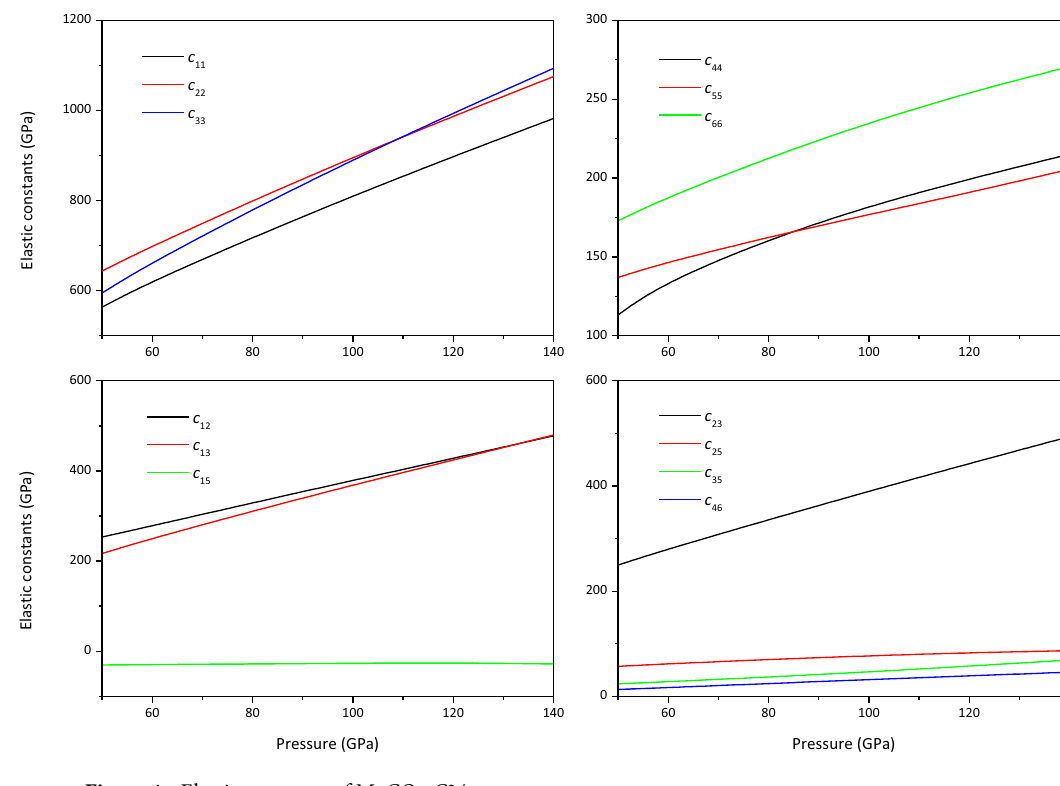
Figure 4. Elastic constants of MgCO 3 - C 2 /m.